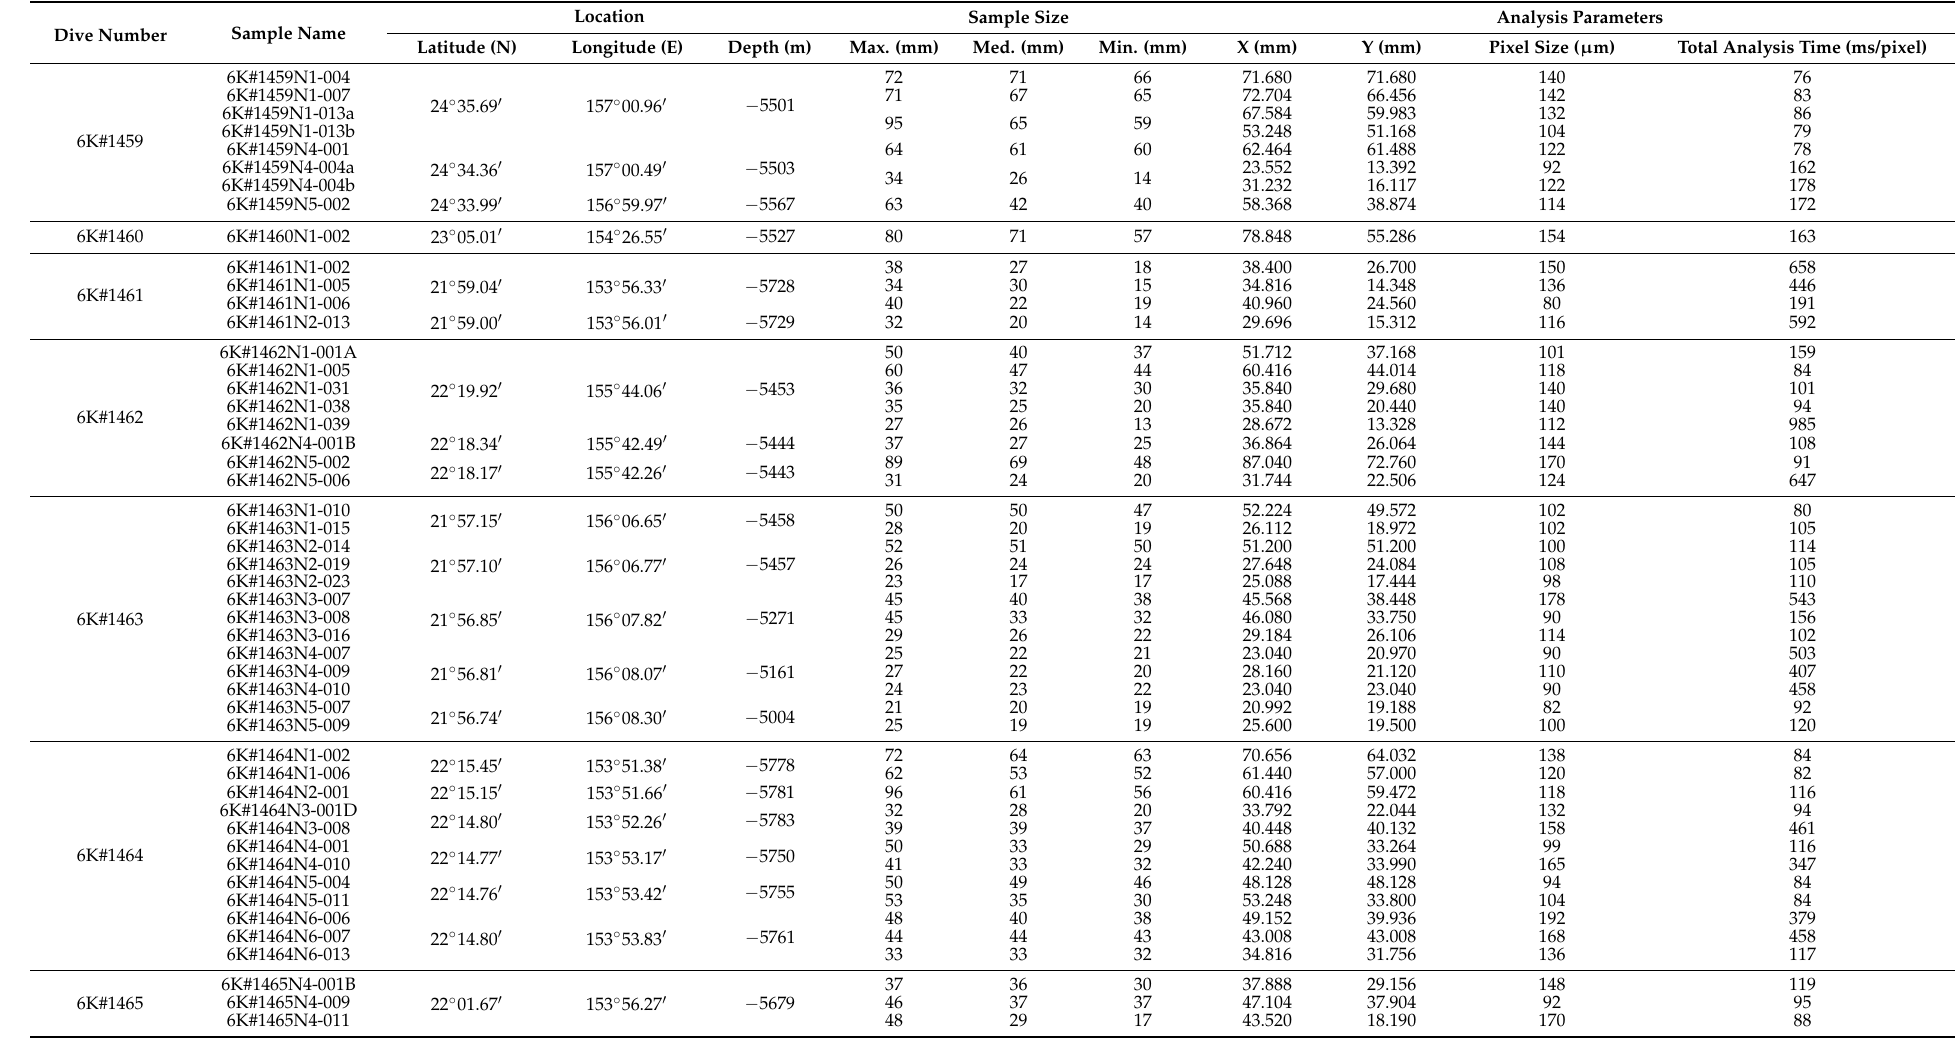
Table 1. Summary of sampling sites for collection of ferromanganese nodule samples, and parameters for µ -XRF